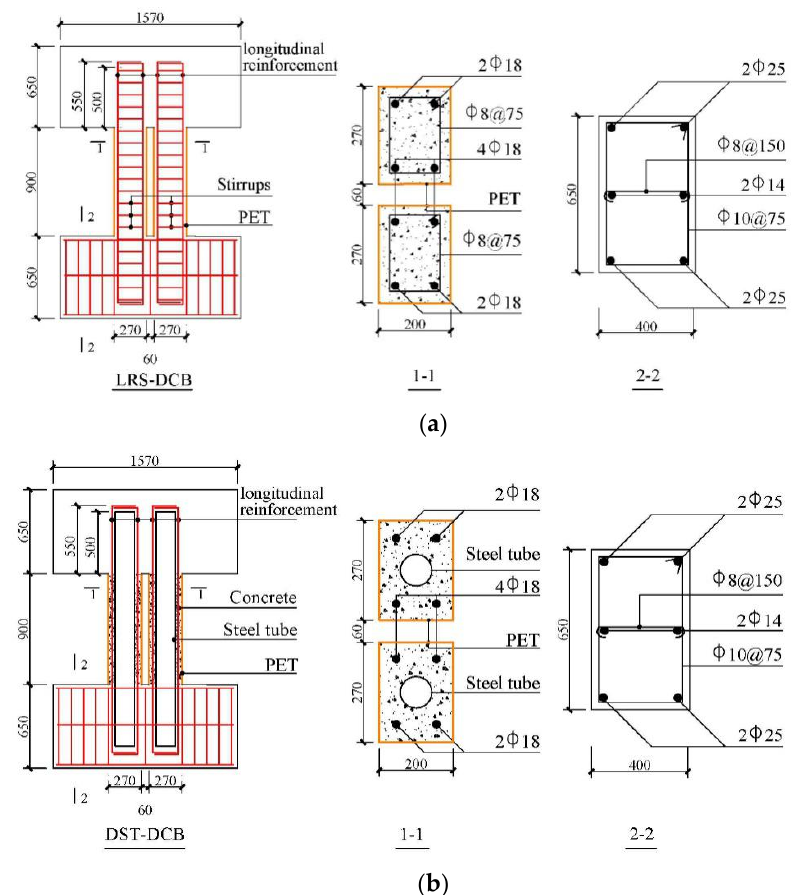
one precast double coupling beam, as shown in Figure 2, with an inner steel tube of 89 mm diameter and wrapped with one PET-FRP sheet. The details of all specimens are listed in